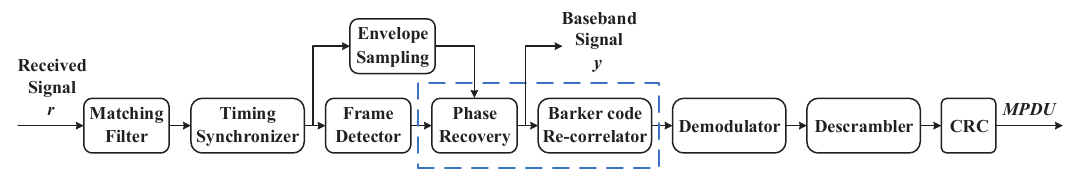
Figure 9. The architecture of baseband